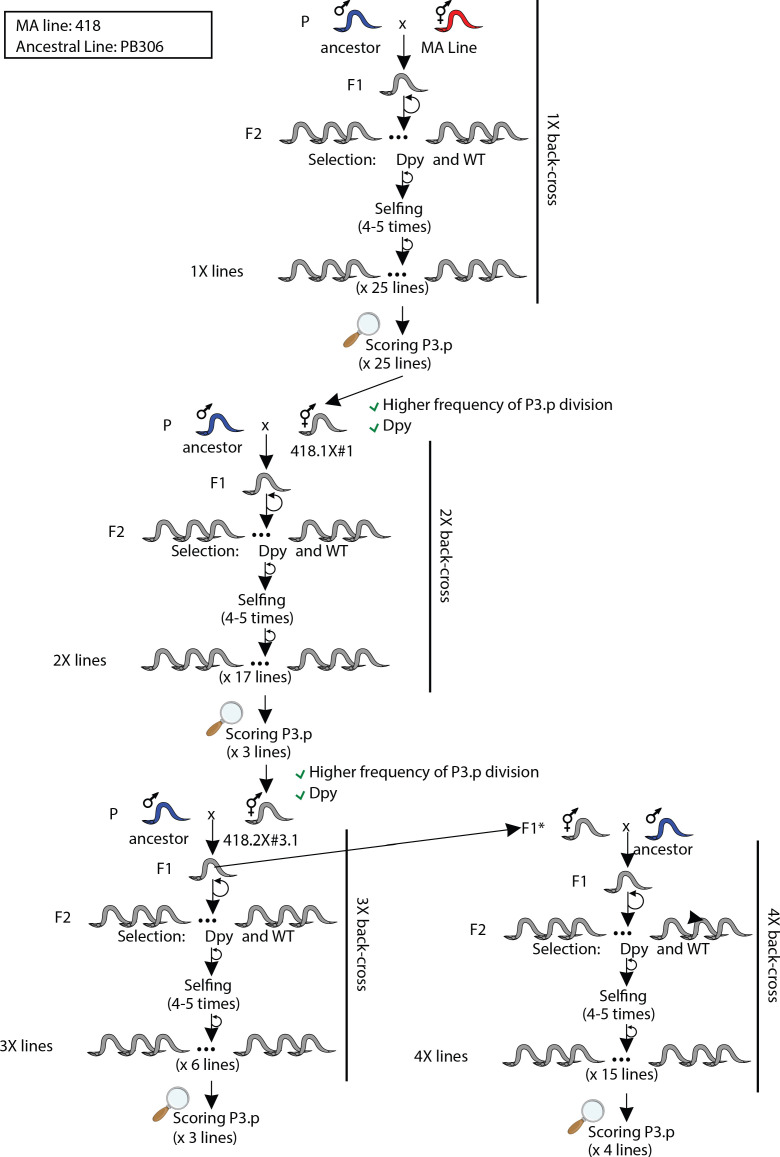
Crossing scheme and selection strategies used to backcross MA line 418 into its ancestral line PB306.The animals designated as F1* were directly isolated to perform another round of backcross. 'Dpy': Dumpy. 'WT': wild-type. '2X' refers to the number of backcrosses.